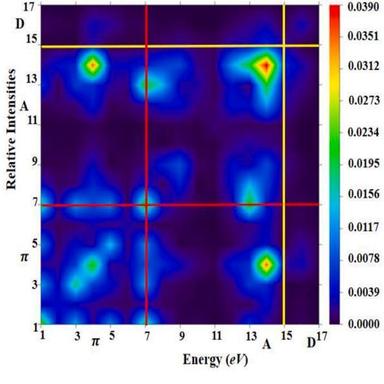
TDM graphs of all the synthesized compounds (EHT1-EHT5).